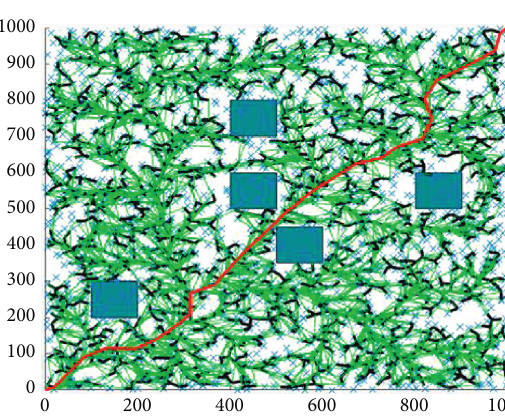
Figure 8: The path planned by NPQ-RRT ∗ .